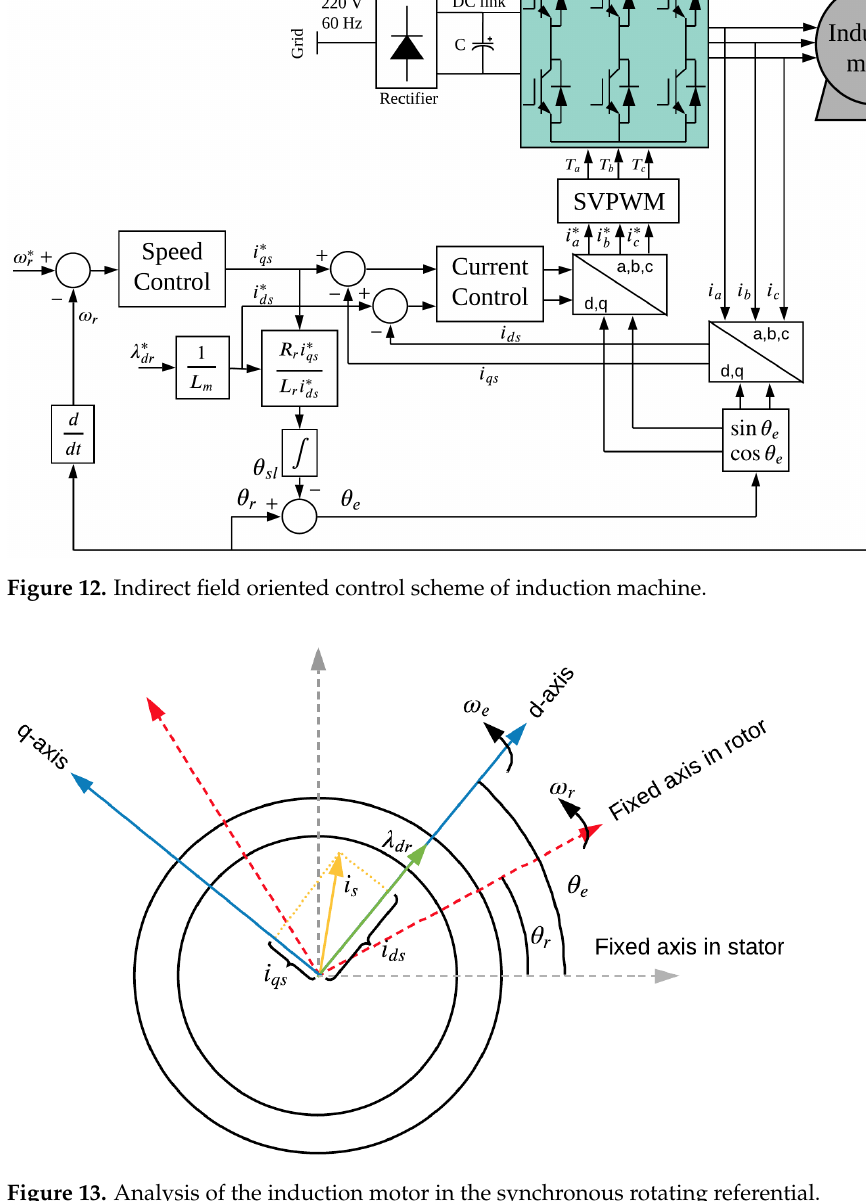
Figure 13. Analysis of the induction motor in the synchronous rotating